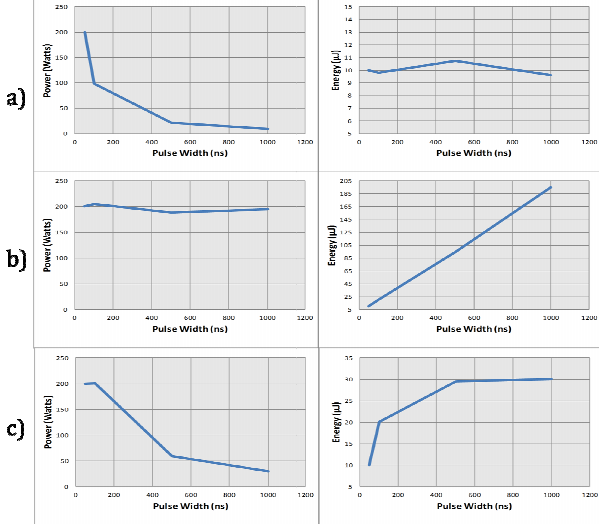
Figure 8: Measurement